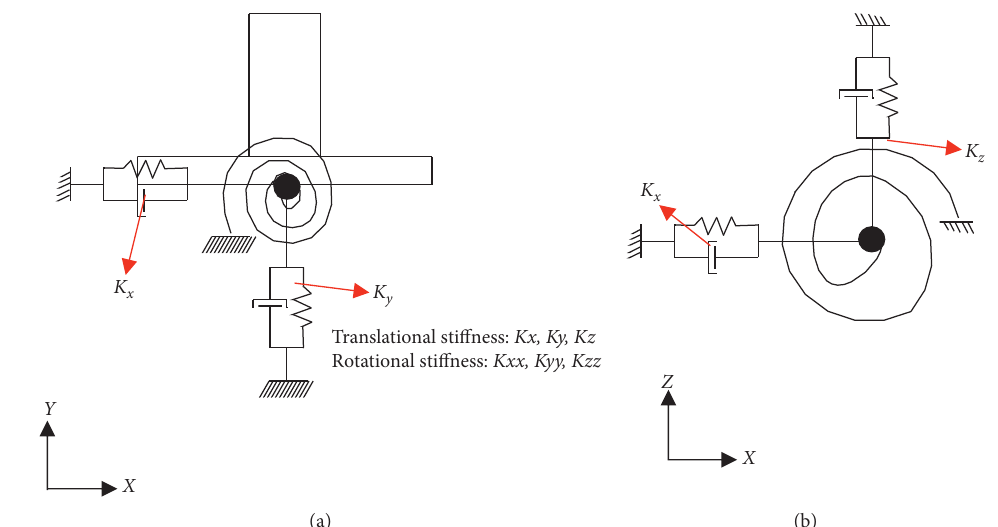
Figure 6: Six-spring model of the pile foundation: (a) elevation and (b) plan view.